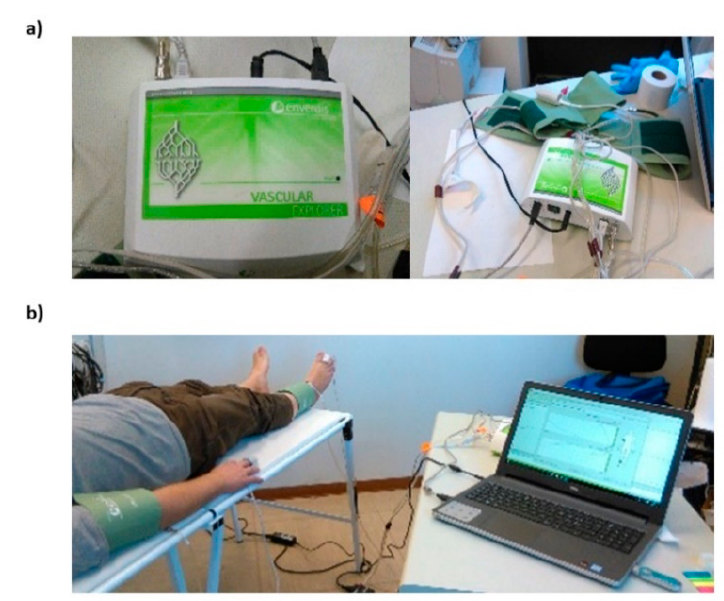
Figure 1. ( a ) Pictures of the Enverdis Vascular Explorer device; ( b ) example of the Vascular Explorer probes and cuffs placement on a participant.